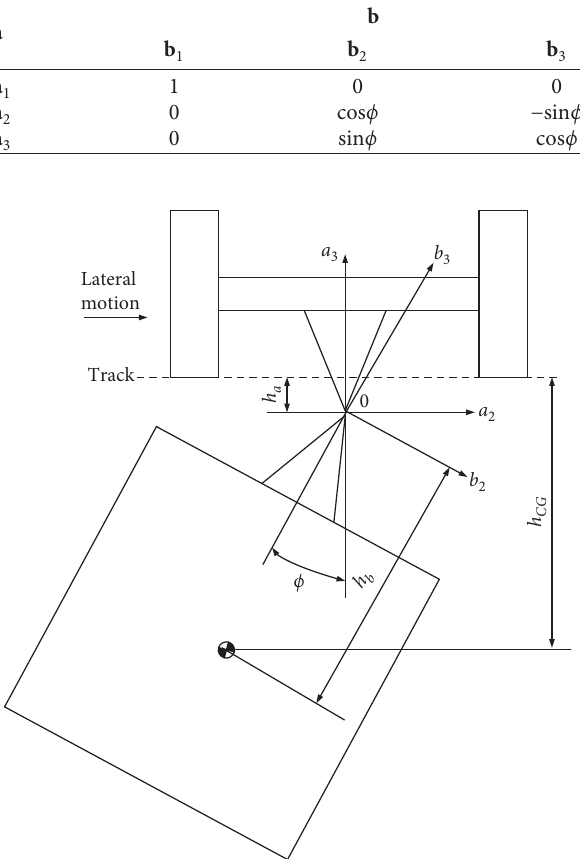
Figure 2: Parameters of the vehicle. h a : distance from the center of rotation to the track, h b : distance from the mass center of the carriage to the center of rotation, and h CG : distance from the mass center of the carriage to the